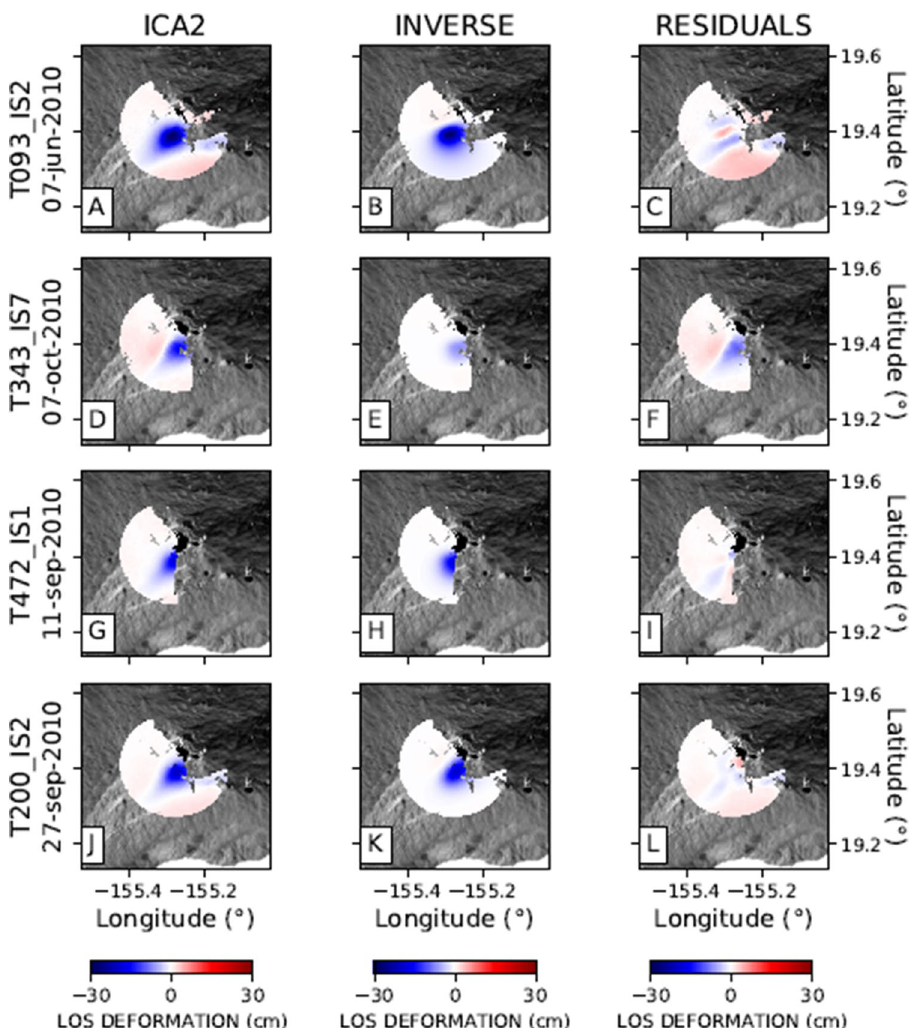
Figure 6. Inverse modelling of the Kīlauea ground deformation source for four selected tracks: ( A ), ( B ), ( C ): ENVISAT 093 orbit; ( D ), ( E ), ( F ): ENVISAT 343 orbit; ( G ), ( H ), ( I ): ENVISAT 472 orbit; ( J ), ( K ), ( L ): ENVISAT 200 orbit, respectively. Column 1 represents the first component (ICA2) encompassing a radius of 15 km from Halema’uma’u Crater. Column 2 represents the inverse model. Column 3 shows the